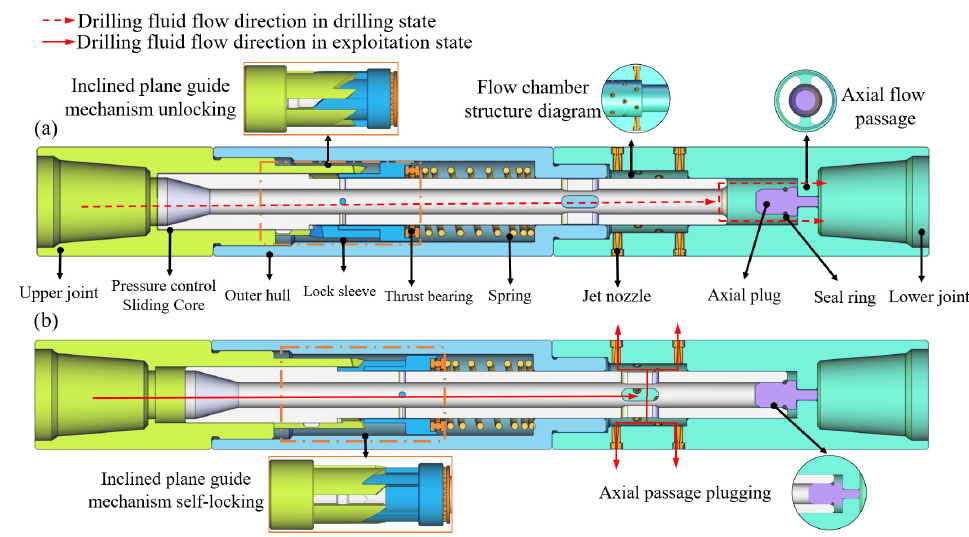
Figure 2. Structure diagram of PCIT: ( a ) PJCT in closed state, ( b ) PJCT in opend state